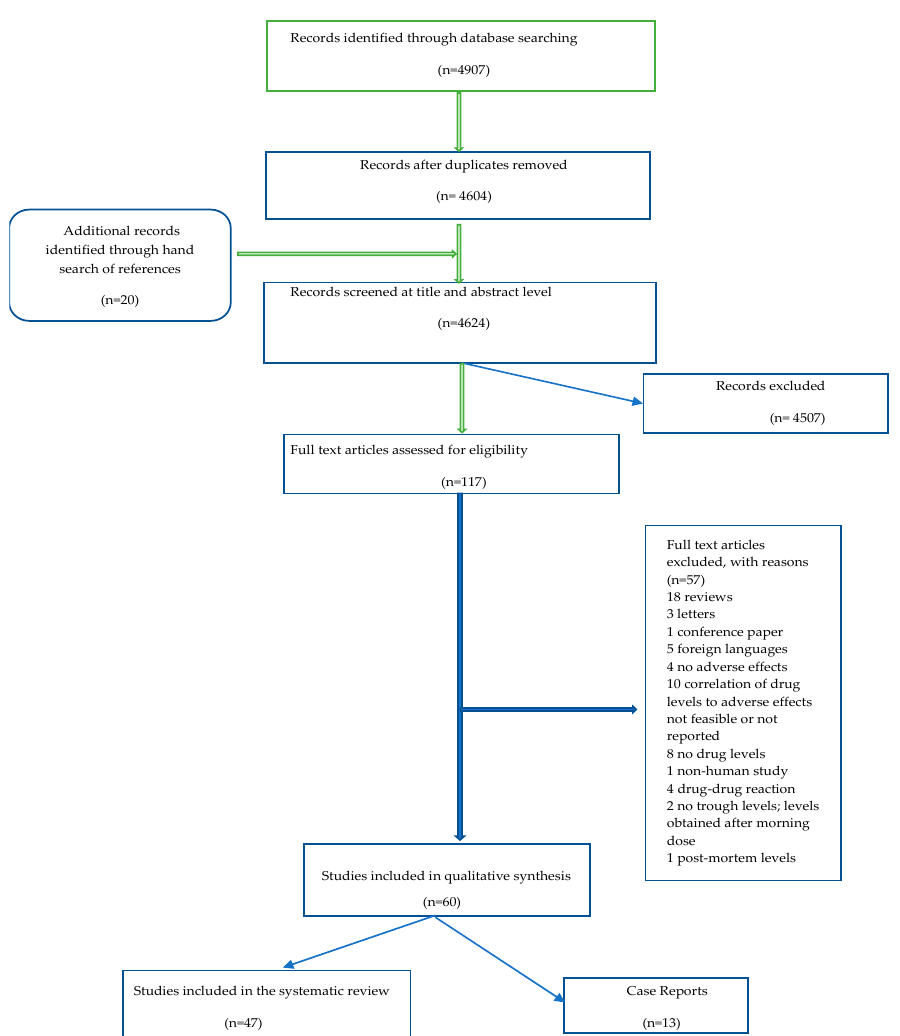
Figure 1. Flowchart of search strategy and article selection.